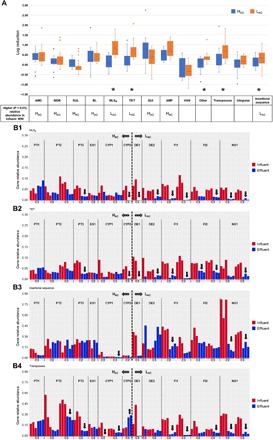
Variation in average ARG prevalence between influent and effluent [log10(influent − effluent)] in HAC and LAC countries.(A) Comparison of ARG log reduction values in UWTPs of the HAC and LAC countries, where zero indicates that treatment did not affect the cumulative ARG relative abundance, positive values indicate a reduction, and negative values indicate an increase. The classes for which HAC or LAC presented higher relative abundance in the influent (P < 0.01, Mann-Whitney U test) are indicated in the table at the bottom. Asterisks indicate statistically significant differences between HAC and LAC log reduction values, and these cases are detailed in (B). (B) Comparison of average ARG relative abundance in influent and final effluent, for the classes with significantly different log reduction values in the HAC and LAC samples: (B1) MLSB, (B2) tetracyclines, (B3) insertion sequences, and (B4) transposase. The arrows indicate significant (P < 0.01; Welch’s t test) increases (↑) or decreases (↓) after treatment (C1, autumn of 2015; C2, spring of 2016; C3, autumn of 2016). WW, wastewater.